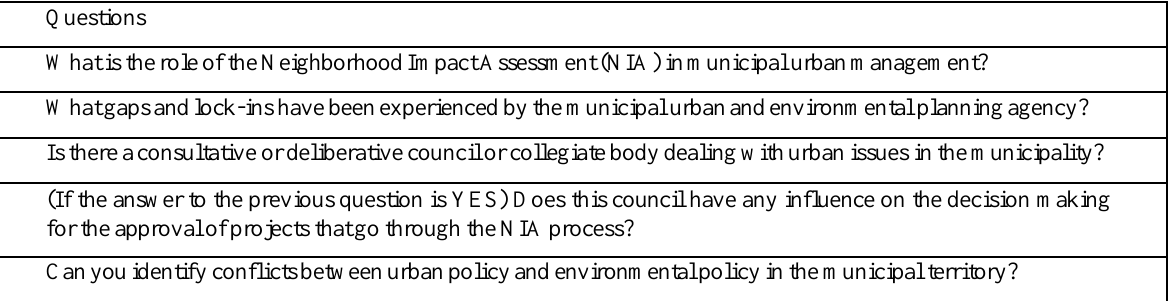
Table 1 - Semi-structured interview